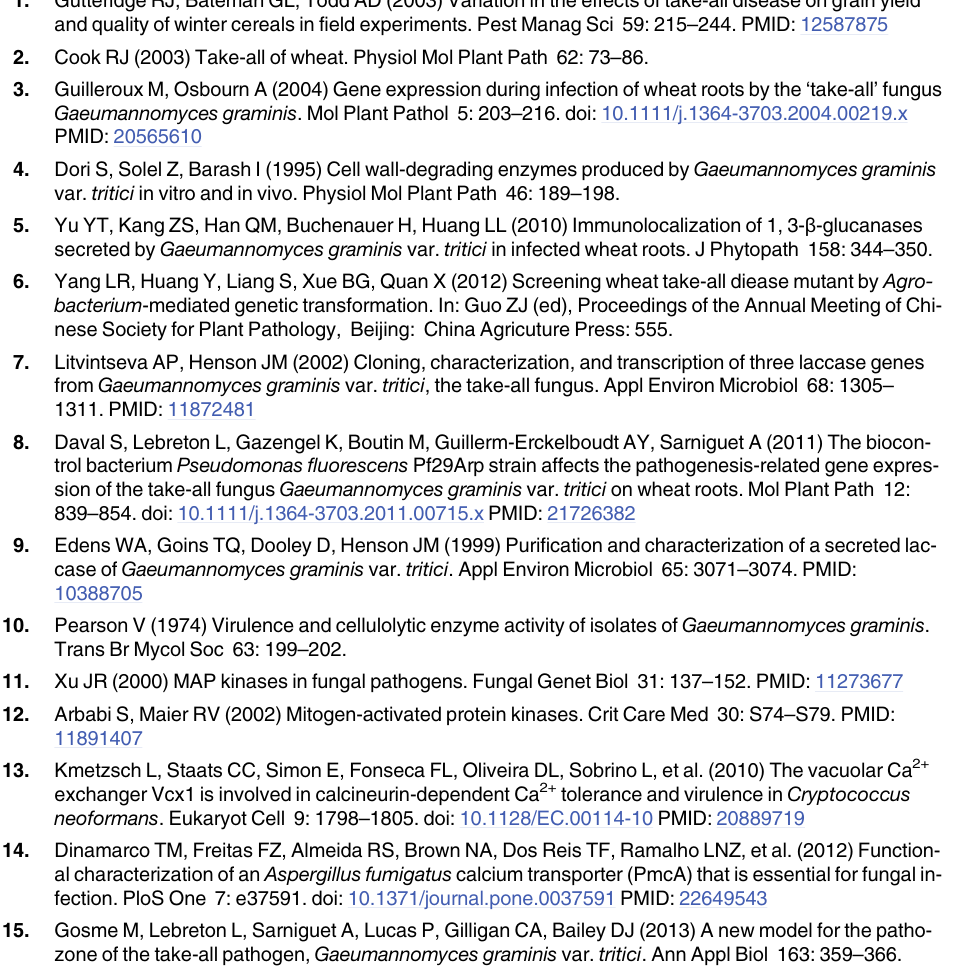
S3 Table. DEGs for signal transduction pathways, plant cell wall degradation and response to plant defense